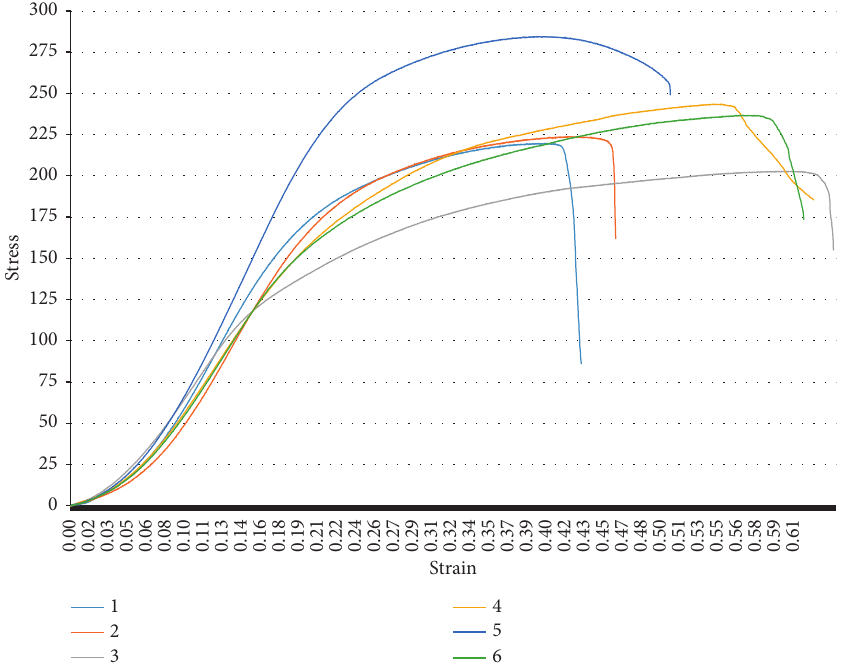
Figure 6: Engineering stress-strain curves from tensile testing of samples: (a) 1, (b) 2, (c) 3, (d) 4, (e) 5, and (f)